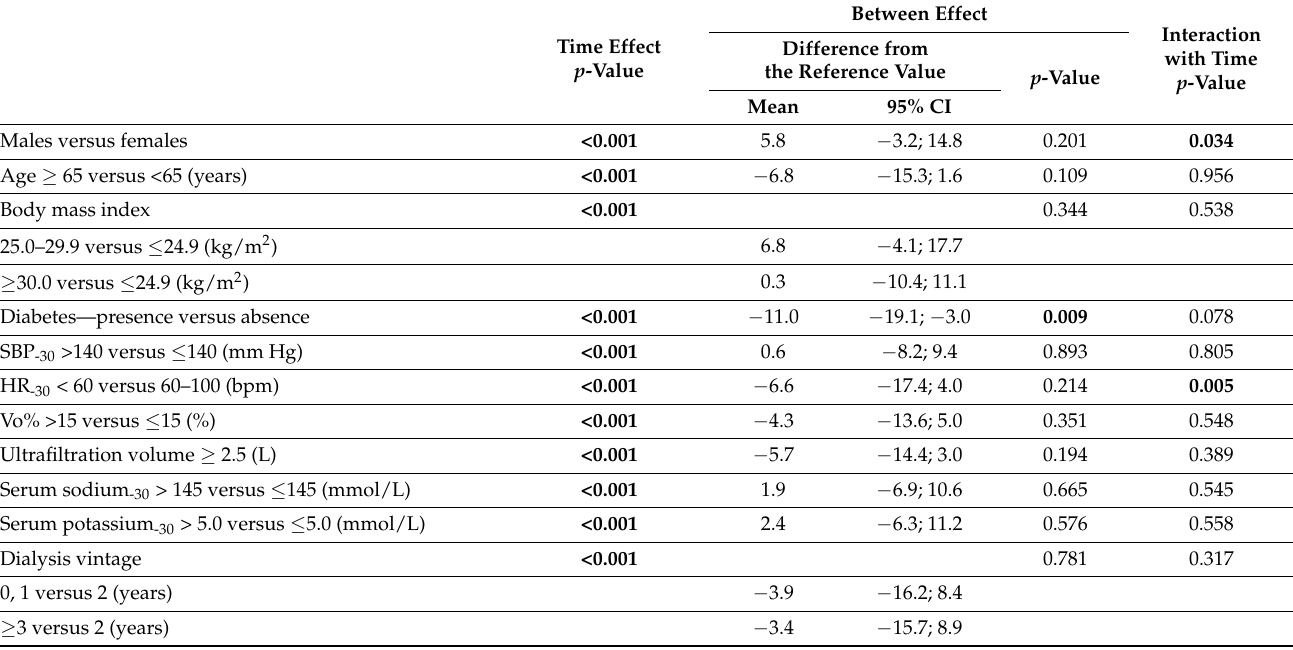
Table 4. Dynamics of diastolic blood pressure during hemodialysis in relation to selected clinical and dialysis